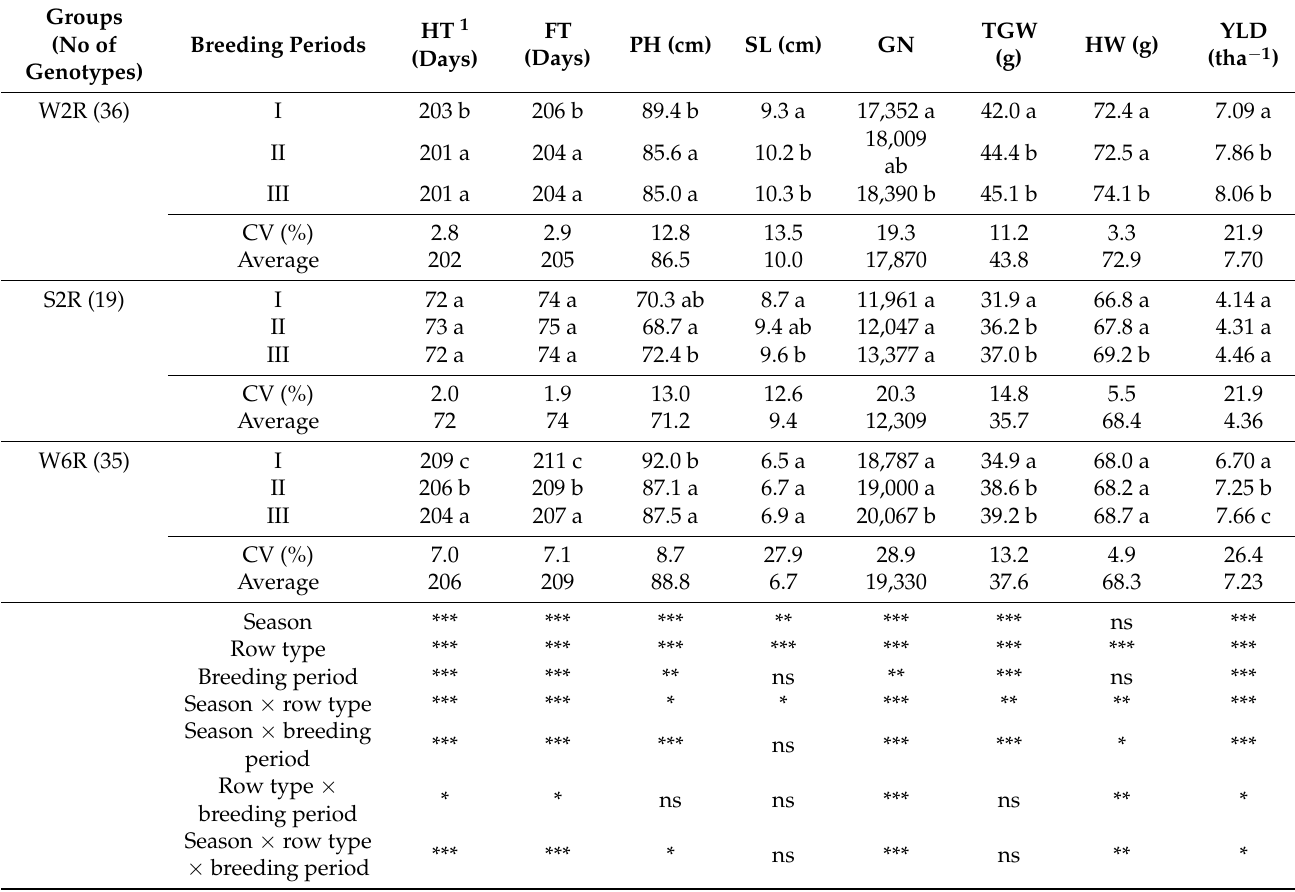
Table 4. Comparison of means for eight agronomical traits of two-rowed winter, two-rowed spring, and six-rowed varieties for different breeding periods and summary ANOVA. Groups (No of